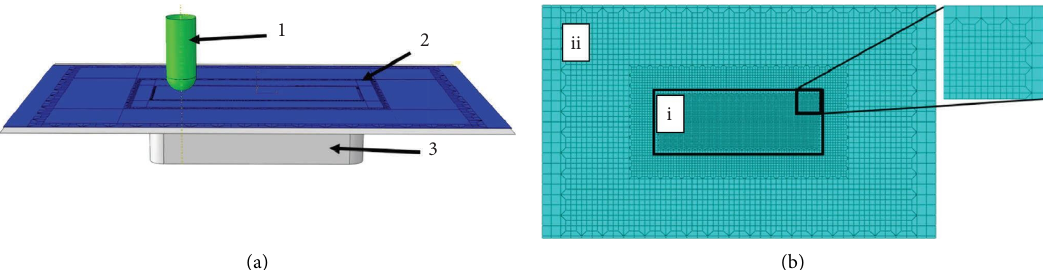
Figure 3: Setup of the simulation of a straight groove: (a) FE model with (1) tool head, (2) metal sheet, and (3) supporting die; (b) Mesh on the sheet with a (area i) fned mesh area and (area ii) large mesh area.